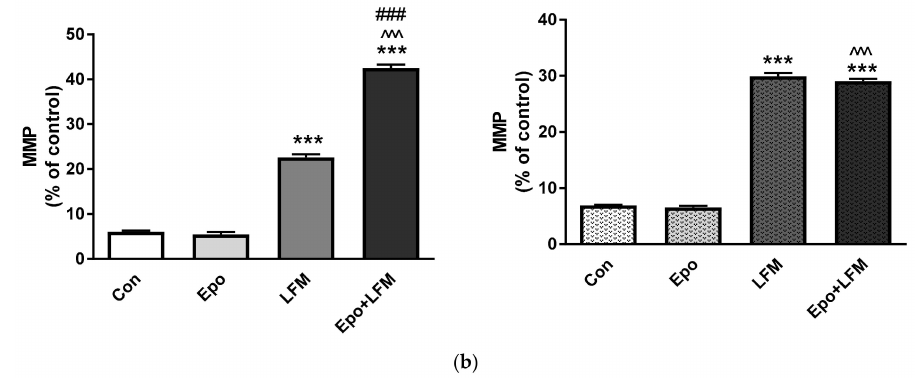
Figure 3. Effect of erythropoietin β (Epo), LFM-A13 (LFM), and their combinations on intracellular pathway and apoptosis. ( a ) Representative flow cytometry dot plots for Annexin V–FITC (fluorescein isothiocyanate) assay of DLD-1 and HT-29 cells incubated with Epo (Epo100, 100 IU/mL) and LFM-A13 (LFM100, 100 µ M) for 48 h (mean ± SD; n = 3). The live cells appear at the lower left corner in the plots; the early apoptotic cells appear at the lower right corner; the necrotic cells appear at the upper left corner; the dead cells appear at the upper right corner. Left panel: The percentage of apoptotic DLD-1 cells incubated with Epo and LFM-A13 is shown in the bar diagram as mean ± SD ( n = 3). Right panel: The percentage of apoptotic HT-29 cells incubated with Epo and LFM-A13 is shown in the bar diagram as mean ± SD ( n = 3); * p < 0.05 (vs. Con), ** p < 0.01 (vs. Con), *** p < 0.001 (vs. Con); ˆ p < 0.05 (vs. Epo), ˆˆˆ p < 0.001 (vs. Epo); # p < 0.05 (vs. LFM-A13), ### p < 0.001 (vs. LFM-A13). ( b ) Representative dot plots presenting the loss of mitochondrial membrane potential (MMP) in DLD-1 and HT-29 cells incubated with Epo (Epo100, 100 IU/mL) and LFM-A13 (LFM100, 100 µ M) for 48 h (mean ± SD; n = 3). Cells with normal MMP are shown on the right side of the plots, cells with decreased MMP on the left side of the plots. The graphs show the percent of cells with decreased mitochondrial membrane potential in DLD-1 (left panel) and HT-29 cells (right